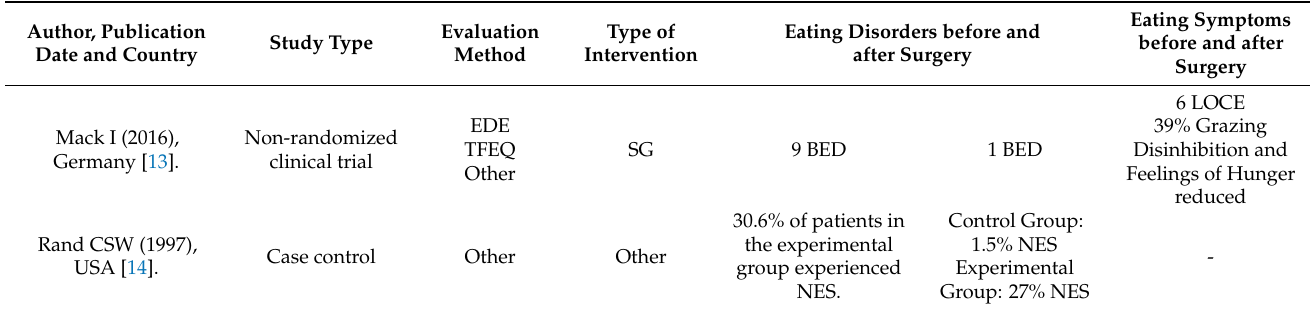
Table 3. Experimental study main results.